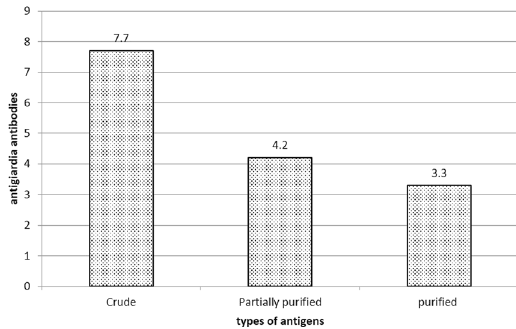
Figure 3. Detection of GA by sandwich ELISA.